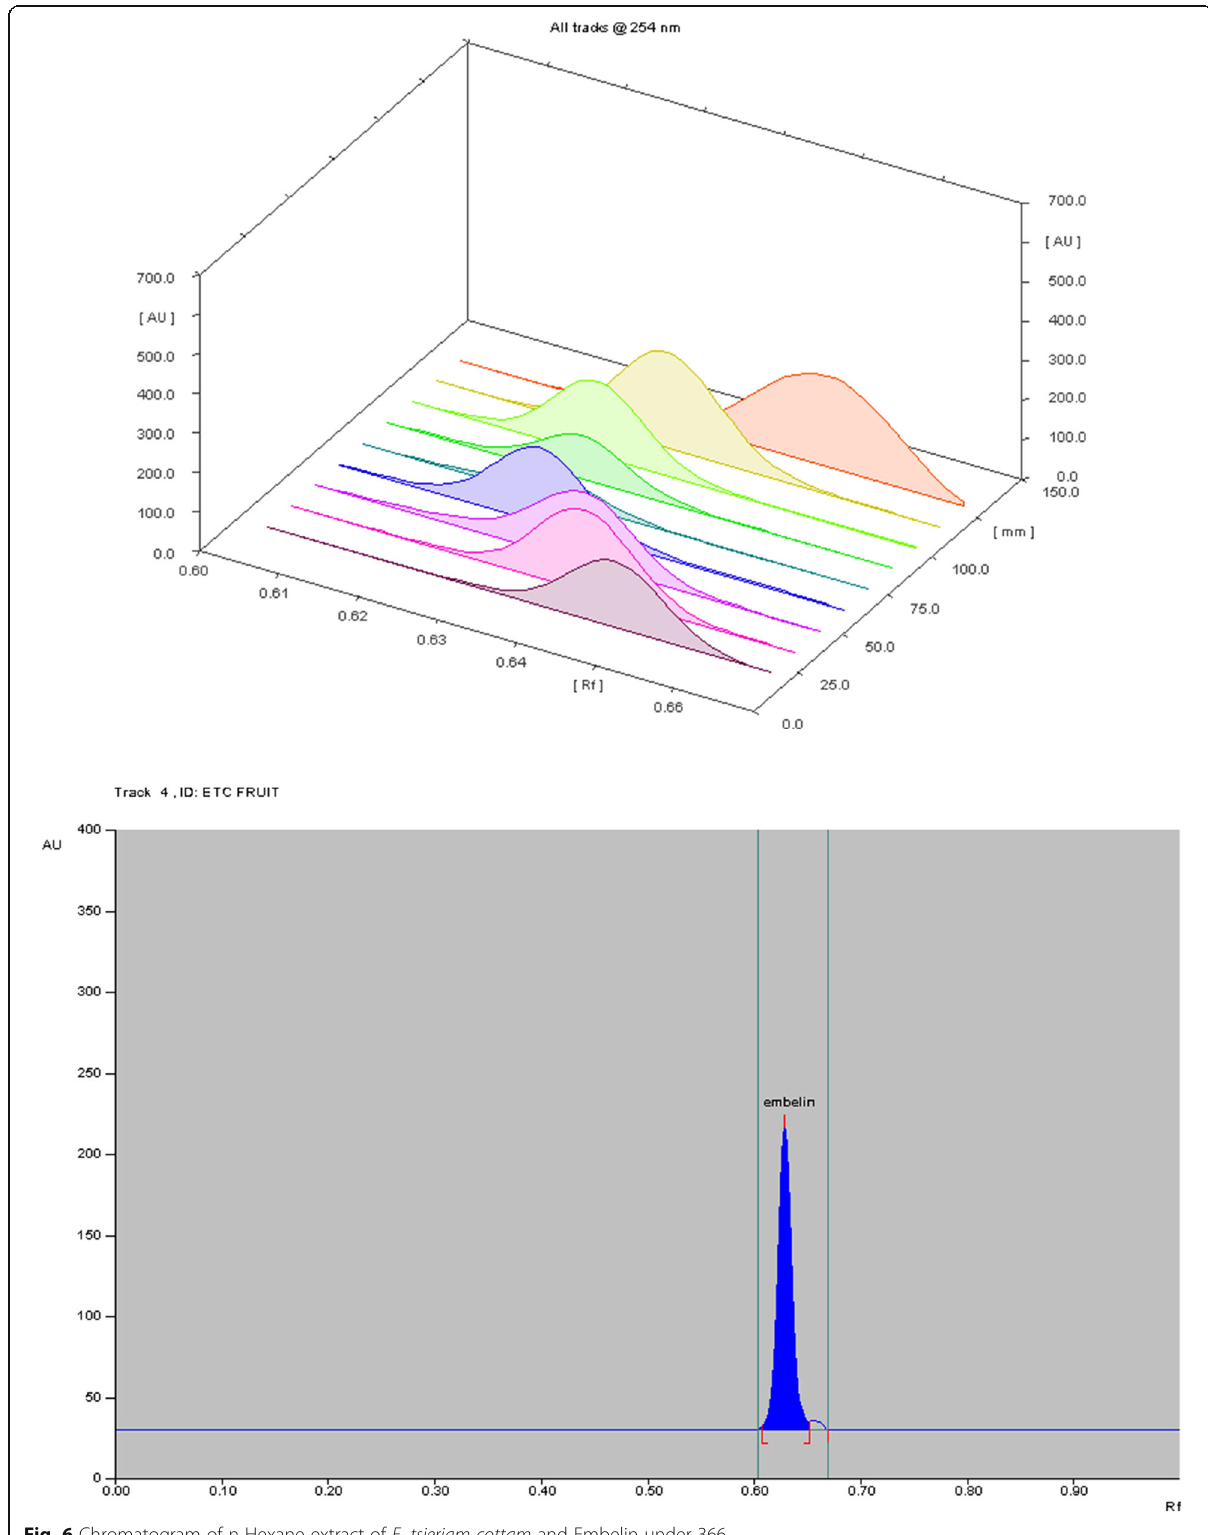
Fig. 6 Chromatogram of n-Hexane extract of E. tsjeriam-cottam and Embelin under